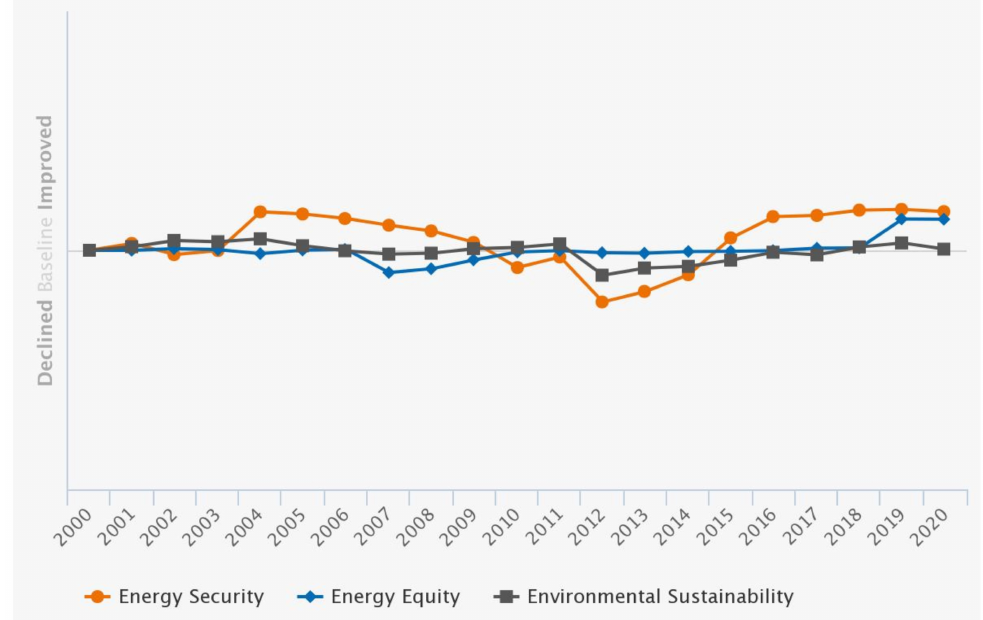
Figure 19. Trends of the components of the Energy Trilemma Index for Lithuania, 2000–2020 (based on